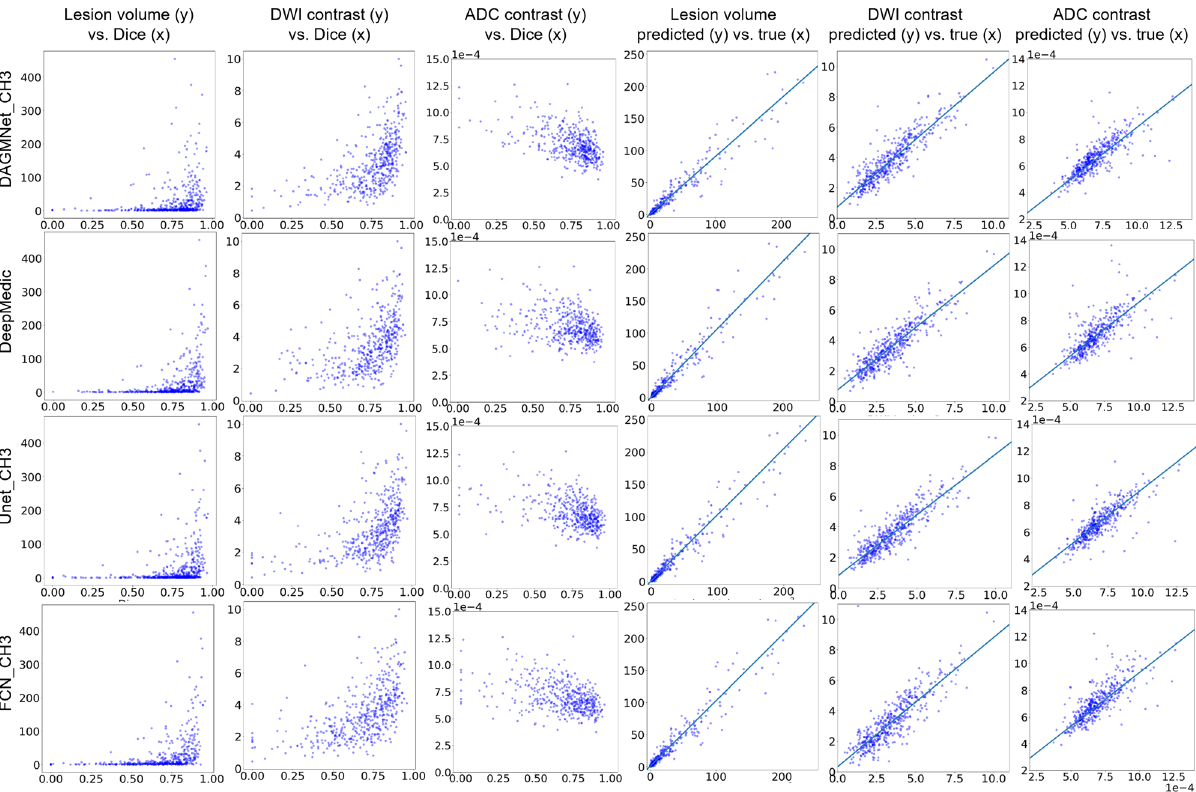
Fig. 6 Correlation between lesion features and segmentation performance, and correlation between lesion features as segmented manually or automatically. The fi rst three columns are scatter plots of lesion features (volume, DWI, and ADC contrast) versus Dice score of the different models (rows) in the Testing dataset ( n = 459). They show how the models perform in lesions of diverse volume and contrast. The last three columns are the metrics of volume, DWI, and ADC of the lesions as traced by human evaluators ( “ true ” ) vs. as predicted by the different models (rows). Volumes are in